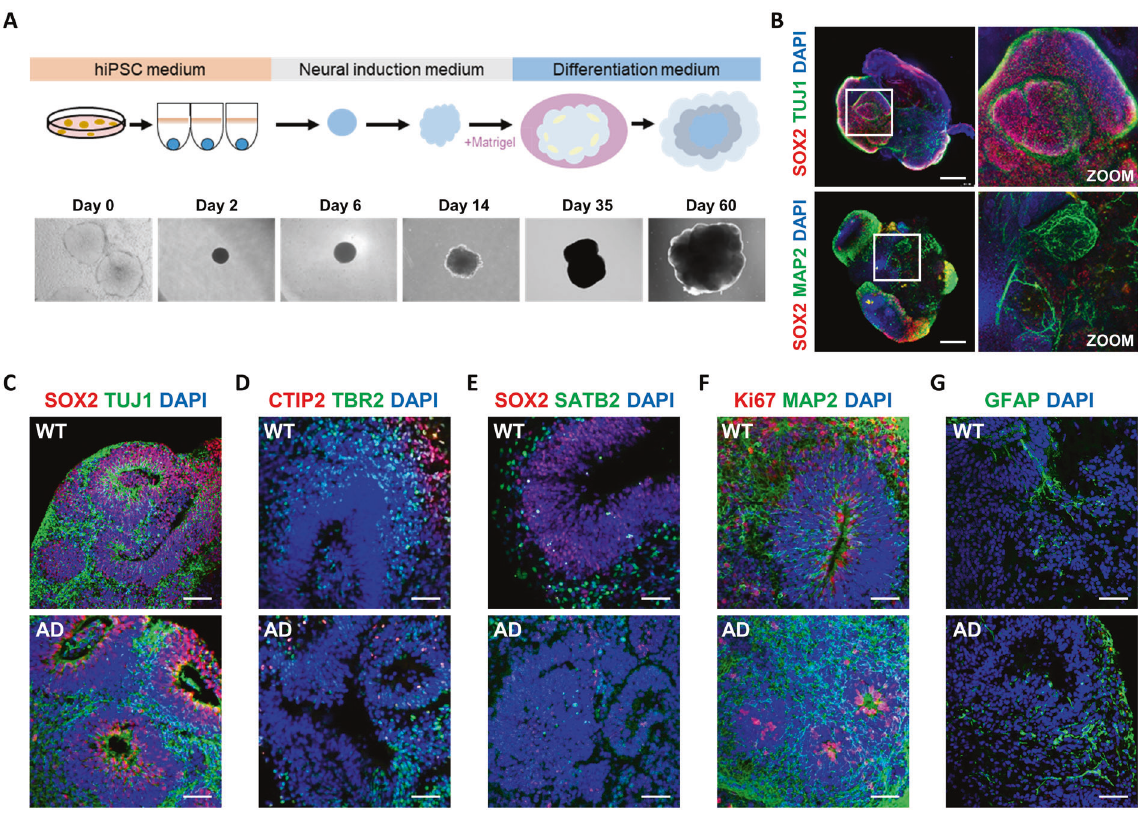
Fig. 1 Generation and characterization of WT and AD hiPSCs-derived brain organoids. A A schematic procedure for generating brain organoids from hiPSCs. Representative bright- fi eld images at different stages. B Clearing of whole organoids immunostained for neural progenitor marker SOX2 and the neuronal marker TUJ1 in WT and AD brain organoids at day 30. Scale bars, 500 µm. C Immunostaining of the neural progenitor marker SOX2 and the neuronal marker TUJ1 in WT and AD organoids at day 60. Scale bars, 100 µm. D Immunostaining of the cortical deep-layer marker CTIP2 and the intermediate progenitor marker TBR2 in WT and AD organoids at day 60. Scale bars, 100 µm. E Immunostaining of the neural progenitor marker SOX2 and the cortical upper layer marker SATB2 in WT and AD organoids at day 60. Scale bars, 100 µm. F Immunostaining of the proliferation marker Ki67 and the neuronal marker MAP2 in WT and AD organoids at day 60. Scale bars, 100 µm. G Immunostaining of the astrocyte marker GFAP in WT and AD organoids at day 60. Scale bars, 100 µm. Every experiment was performed in